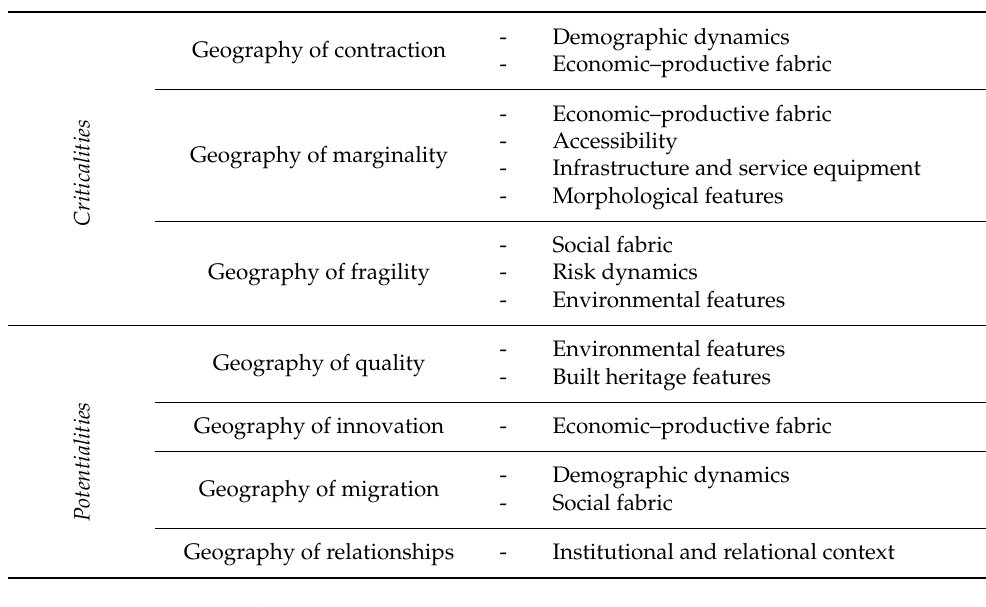
Table 2. Correlation between geographies and